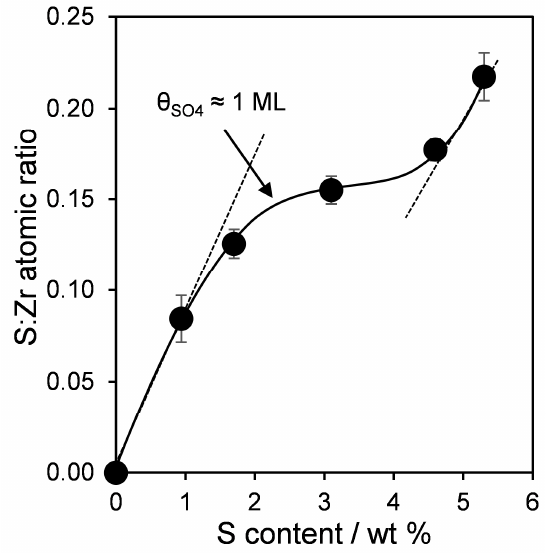
Figure 4. S 2p:Zr 3d XP atomic ratio as a function of bulk S loading.